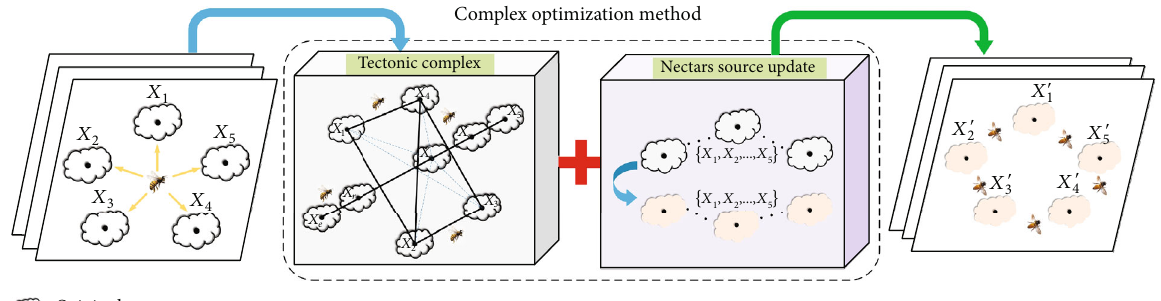
Figure 5: Schematic model of the complex method for fi ve nectar sources.